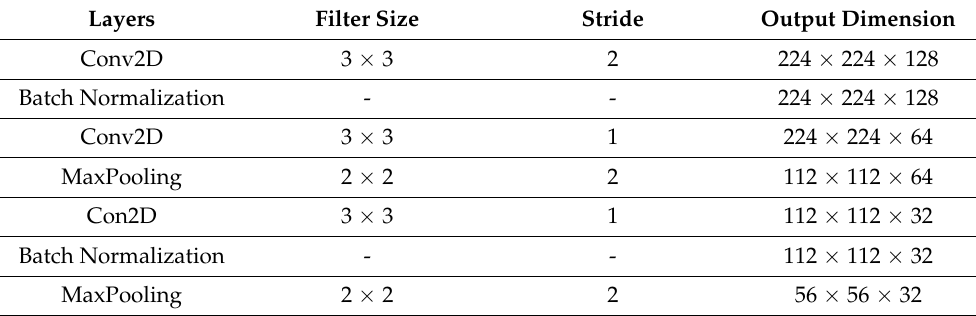
Table 2. Denoising autoencoder layer parameters: kernel size, stride and output dimensions.